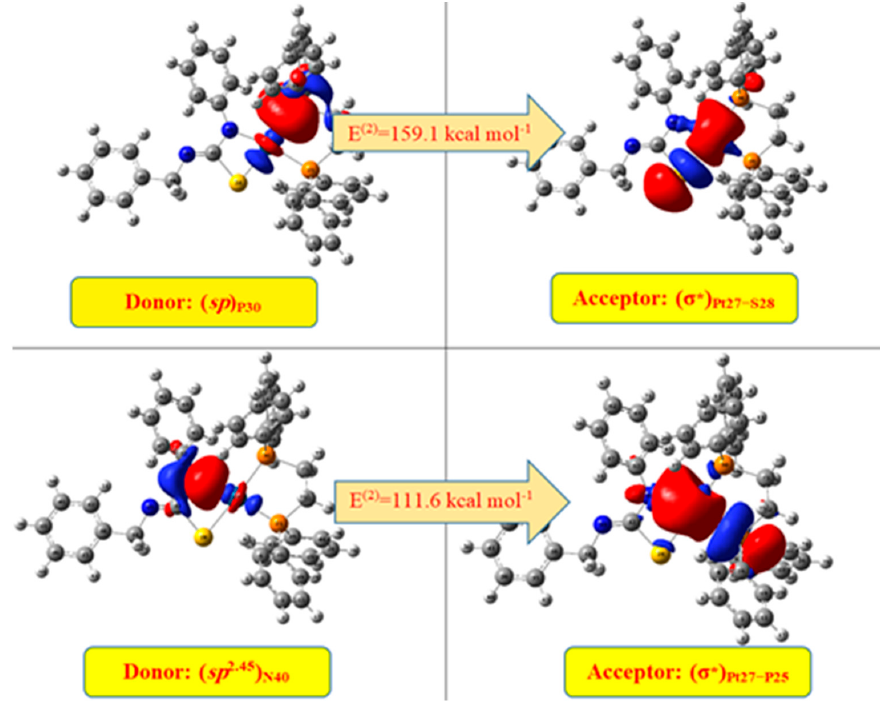
Figure 4. Donor and acceptor orbitals of two highest second-order perturbation energies (E (2) ) of [Pt(BPT)(dppe)] ( 1 ) complex.